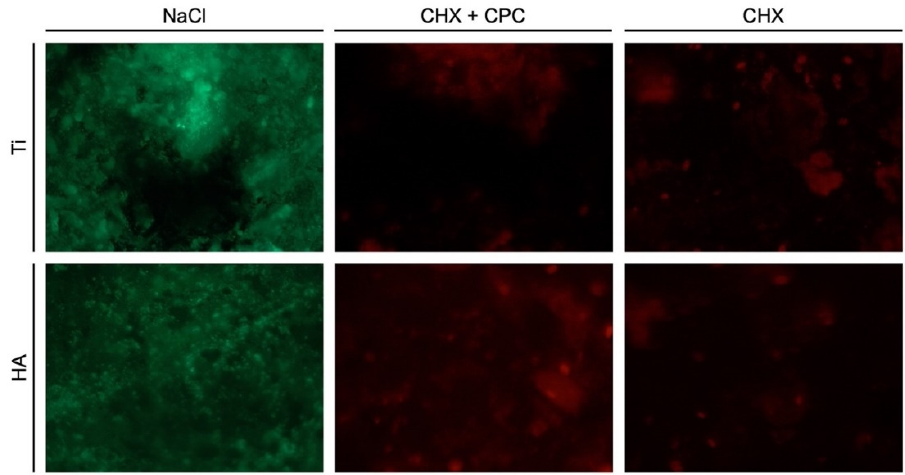
Figure 3. 24-h-old biofilm on Ti and HA surfaces after treatment with NaCl, CHX + CPC or CHX.